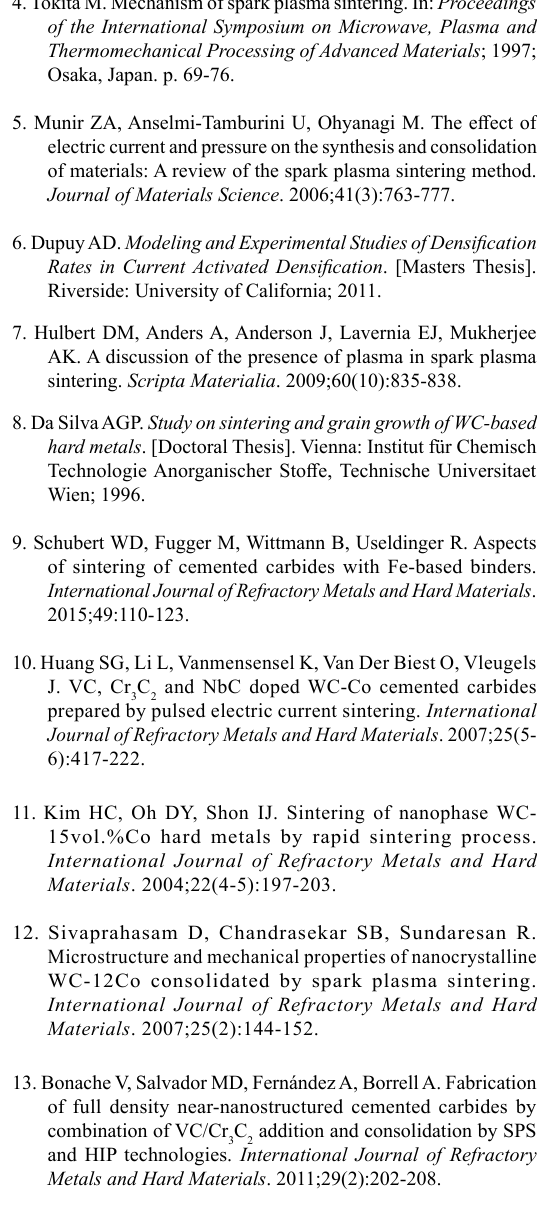
Figure 7. Structure of alloy REC. Particles of the WC0Co powder with different characteristics such as grain size and composition.